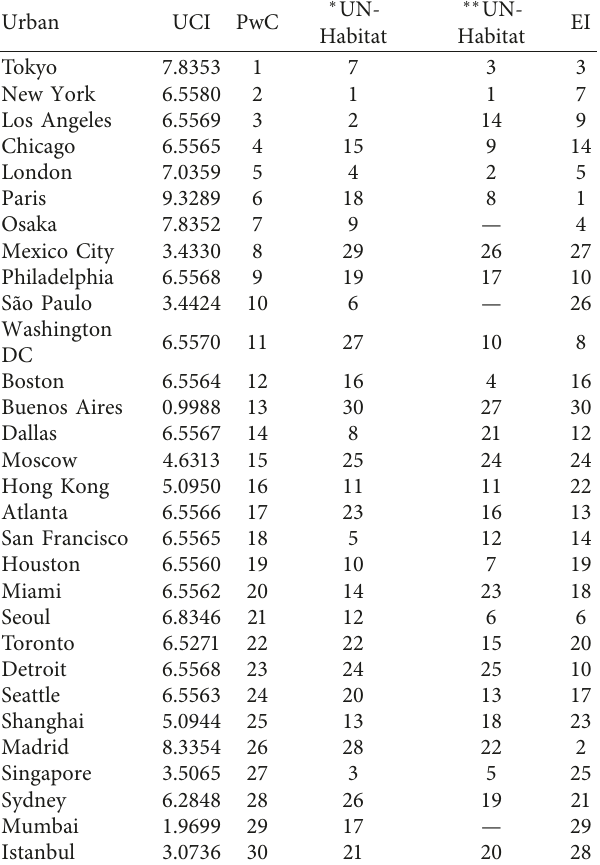
Table 4: Comparisons of ranking of